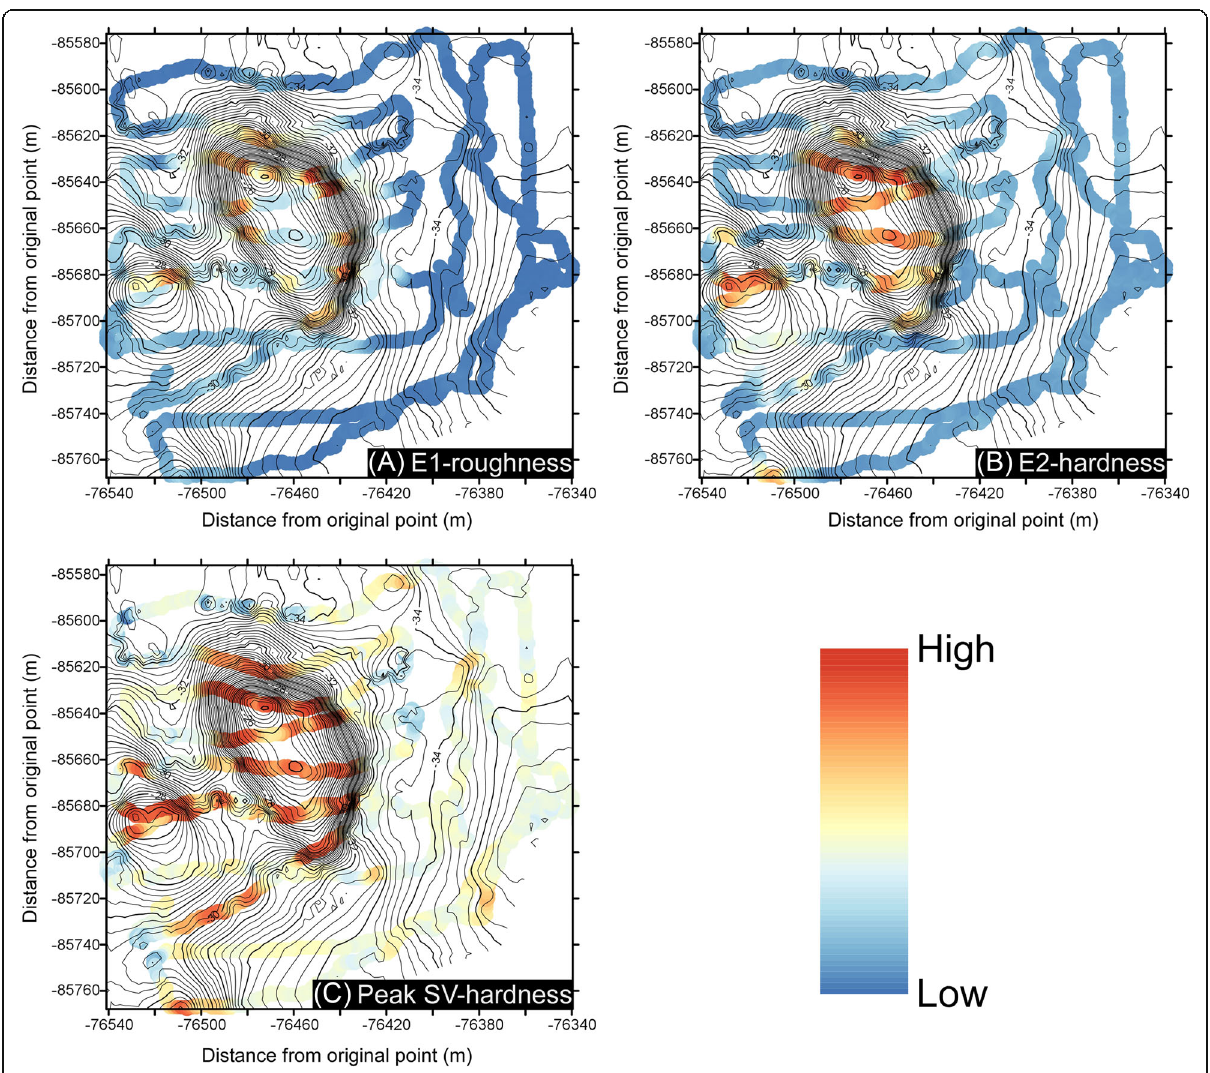
Fig. 6 The results of acoustic bottom analyses obtained by using a 200 kHz acoustic source: a E1 – roughness value, b E2 – hardness value, and c peak SV – hardness value. The results are shown with colored solid circles 6 m in diameter (the area of scanning at a depth of 30 m, the average depth in this